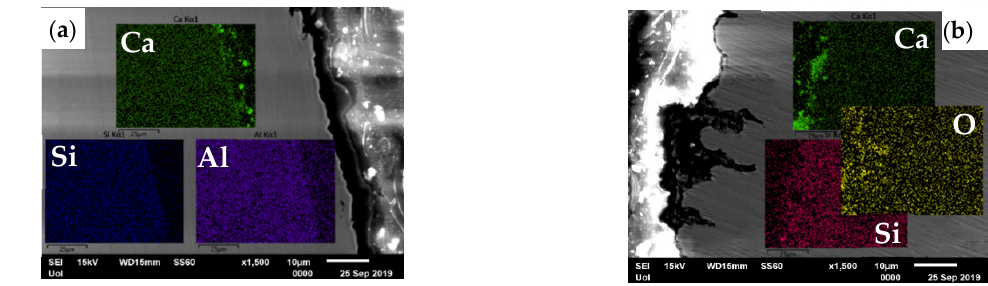
Figure 4. SEM images (cross-sections) of 316L rebars removed from concrete with Inhibitor B and ( a ) 20% FA, ( b ) 25% FA after a salt fog test for a period of 4 months; inset EDX elemental mapping.